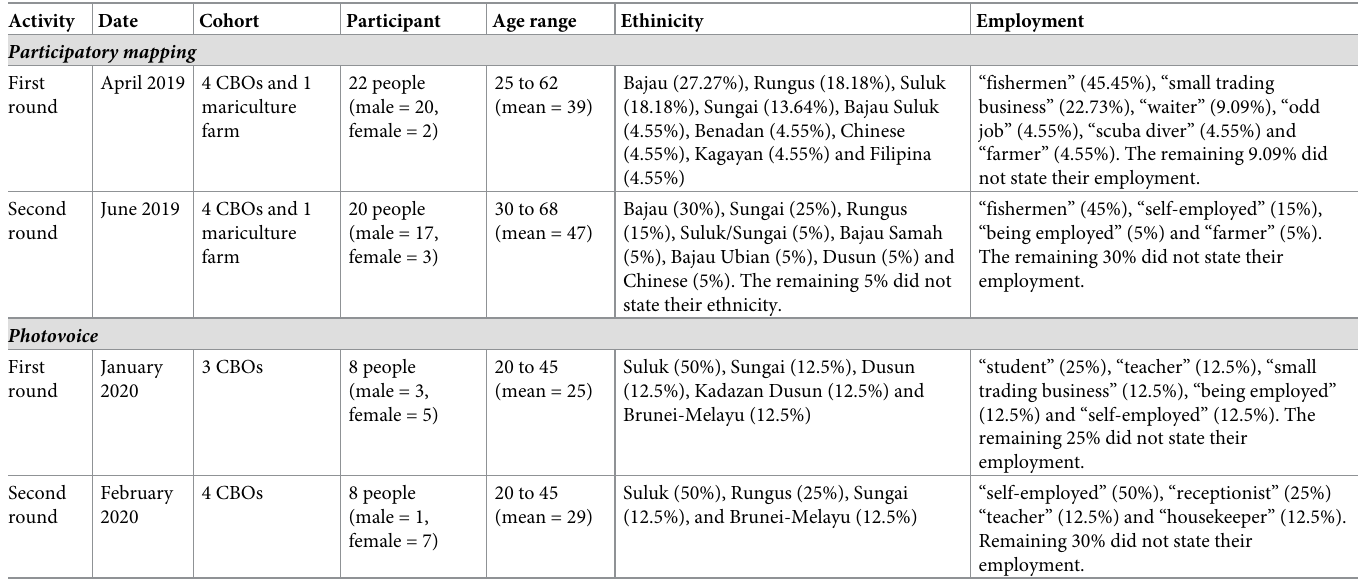
Table 2. Socio-demography of participants who joined the participatory